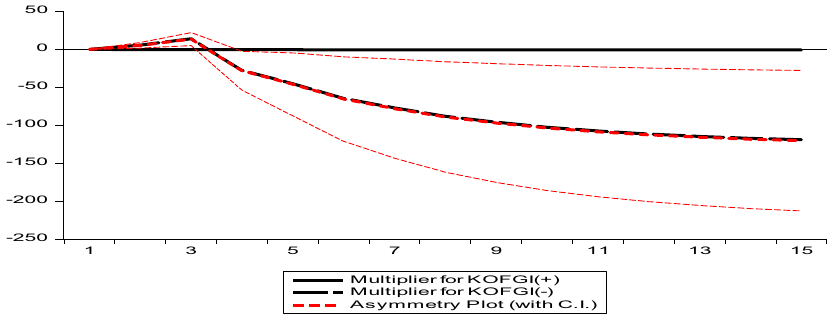
Fig. 4 NARDL dynamic multiplier graph for KOFGI (Source: authors’ illustration from UNDP, WDI, and ETH Zurich KOF data)